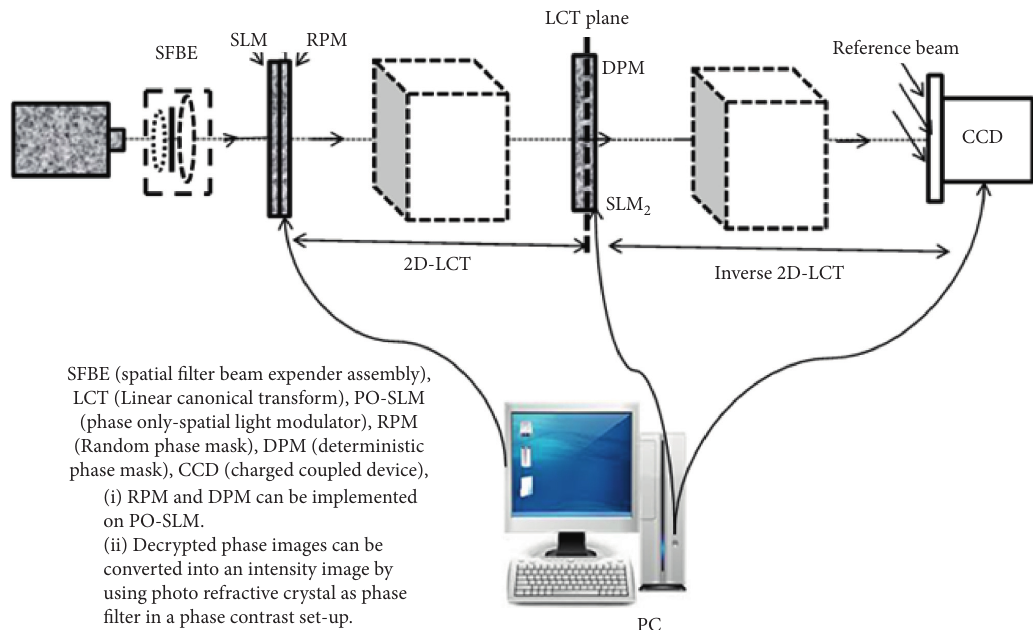
Figure 5: Proposed optoelectronic encryption setup.